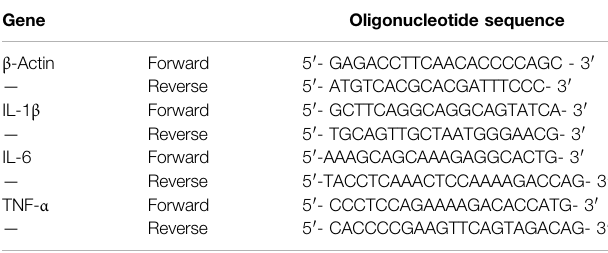
TABLE 1 | List of primers for real-time qPCR analysis. Gene Oligonucleotide